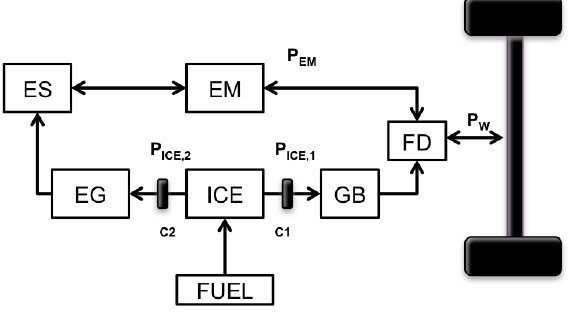
Figure 2. Powertrain architecture of a generic post-transmission series/parallel HEV. EM, Electric Machine; EG, Electric Generator; GB, Gear